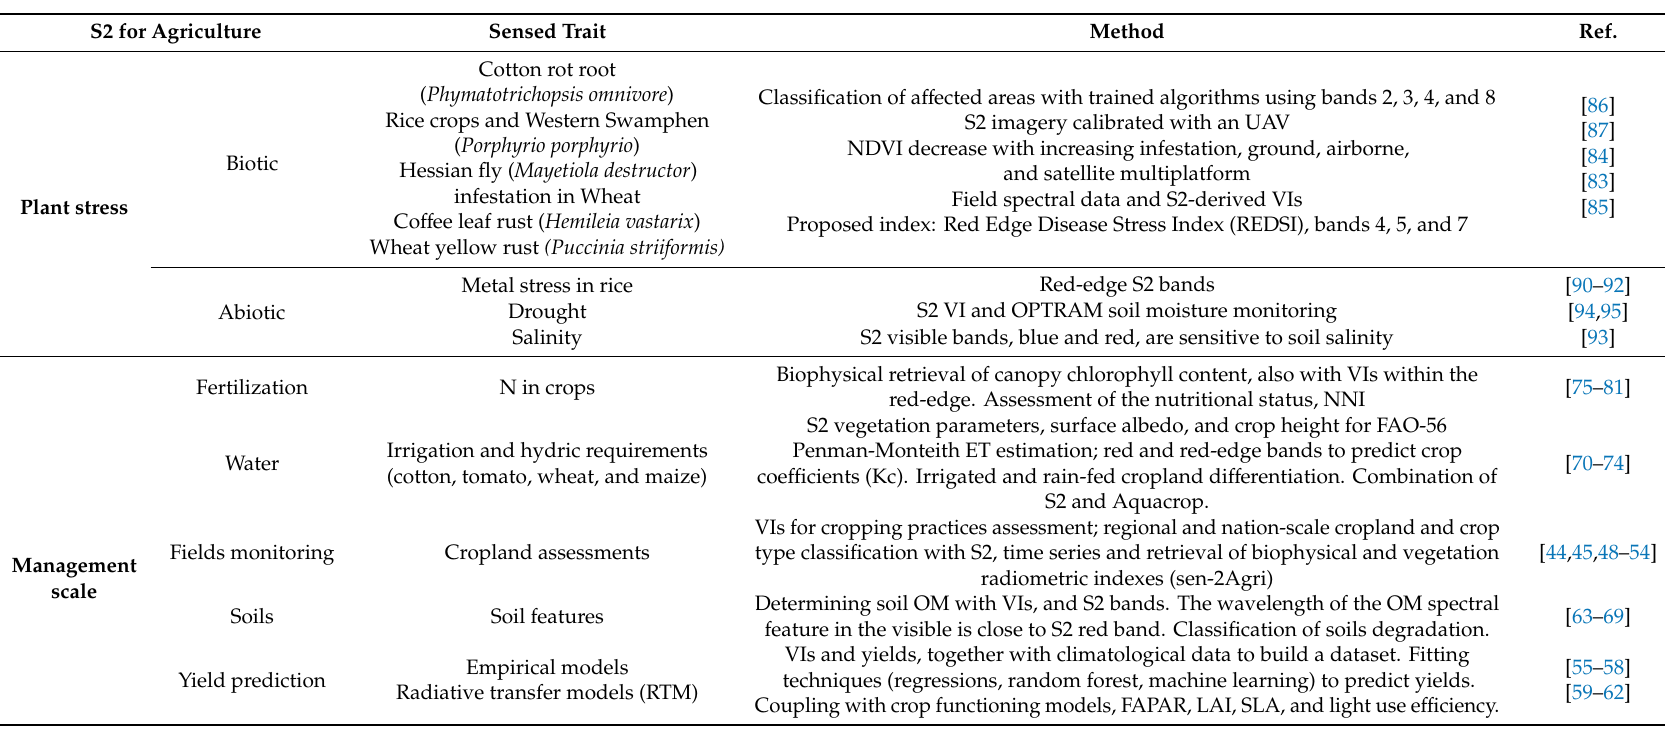
Table 3. Examples of remote sensing information, derived from Sentinel-2, used for crop monitoring and management and the methodological approach